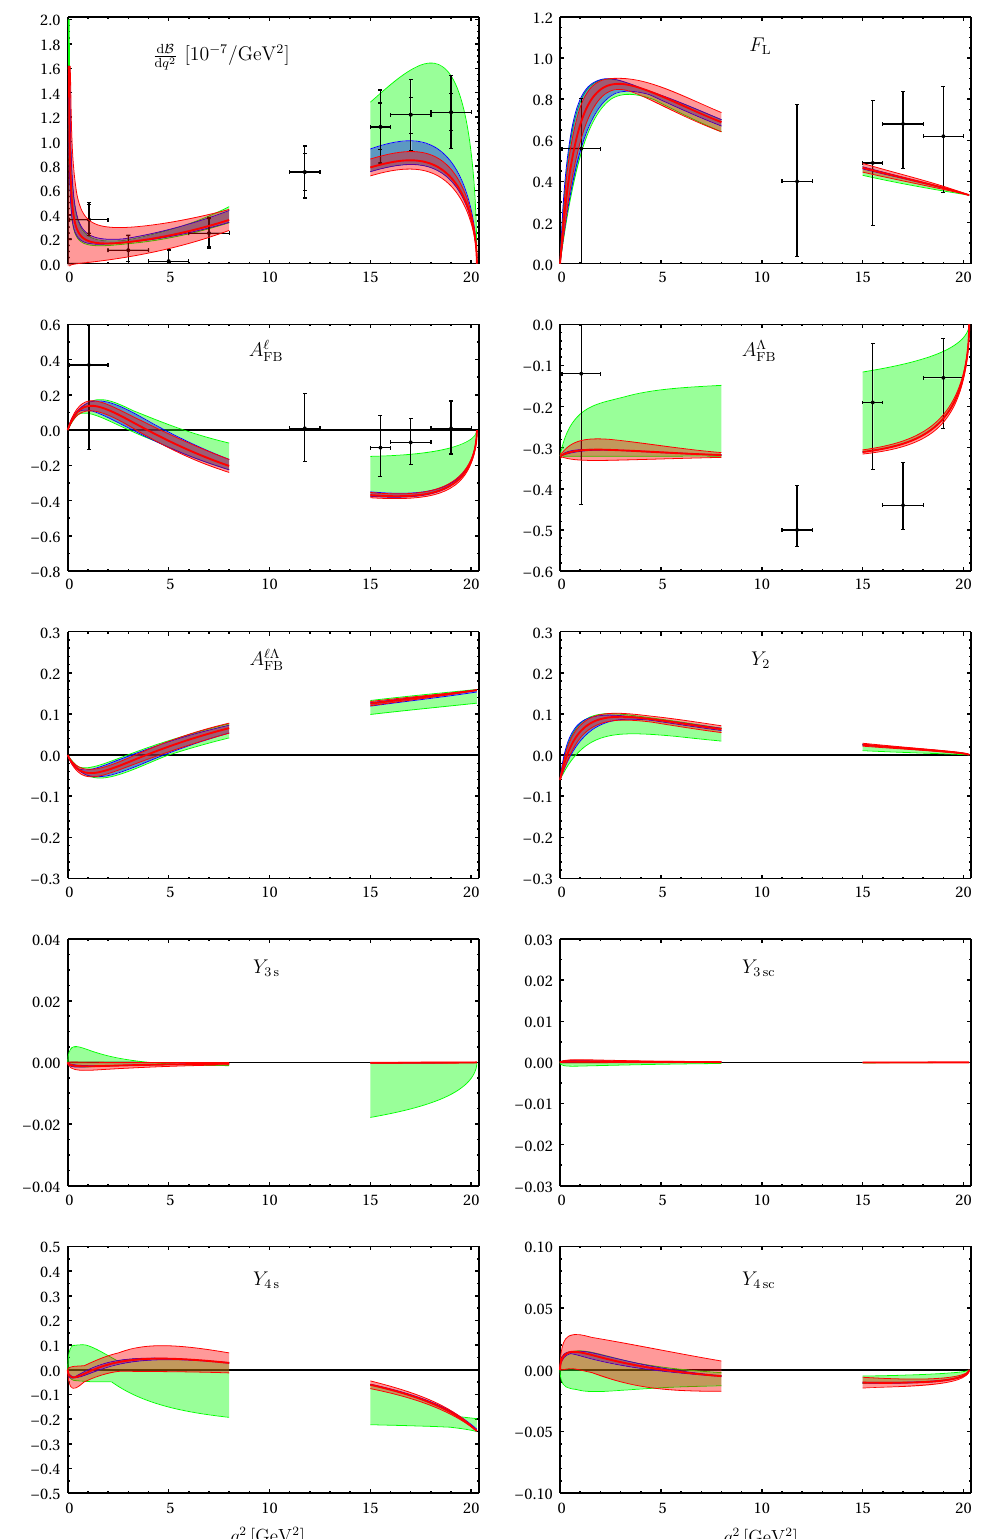
Fig. 2 The (cid:2) b → (cid:2)( → p π − )μ + μ − observables as a function of the dimuon invariant mass squared q 2 , predicted both within the SM (central values: red solid curves , theoretical uncertainties: red bands )